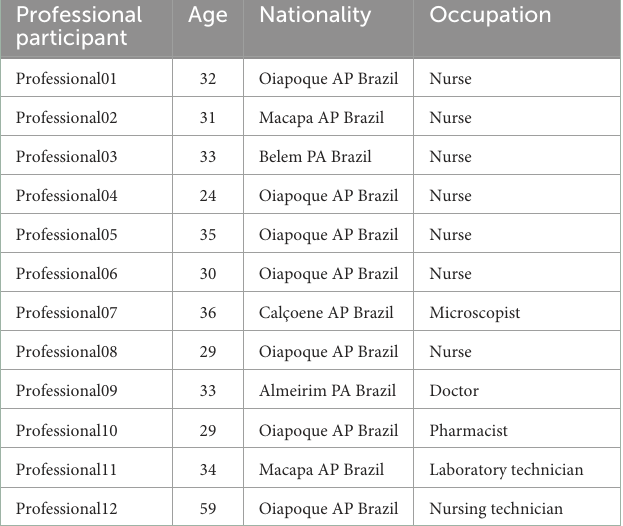
TABLE 2 Age, nationality, and profession of healthcare professionals participating in the scientific research. Professional